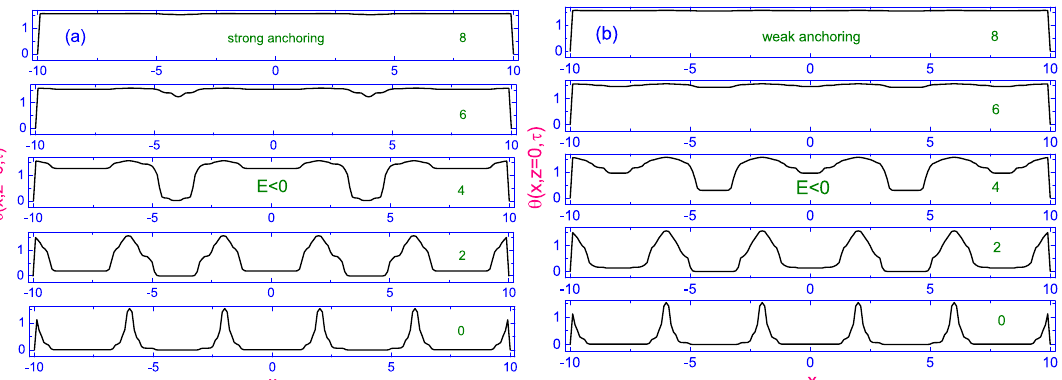
Figure 13. The same as in Figure 12, but plot of the evolution of the polar angle θ ( x,z = 0, τ ) to its equilibrium distribution along the length of the dimensionless nematic film ( − 10 ≤ x ≤ 10 ) , for a number of dimensionless times τ = 0 (250), 2 (252), 4 (254), 6 (256), and 8 (258) [19],